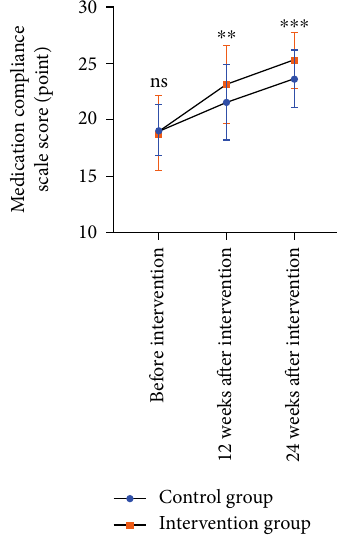
Figure 3: Comparison of medication compliance scale score between the control and intervention group. n = 74 ; ∗∗ p < 0 : 01 and ∗∗∗ p < 0 : 001 . ns: not signi fi